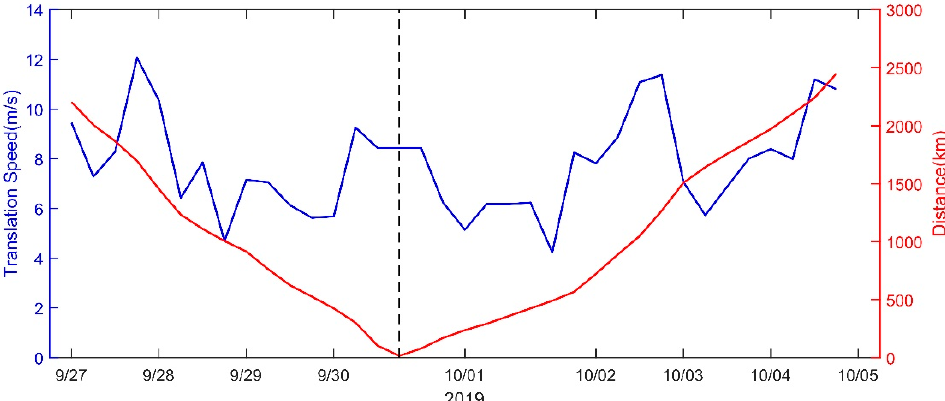
Figure 2. Translation speed (blue solid line) and distance between typhoon Mitag’s center and the mooring over time from when typhoon Mitag was generated. The horizontal axis is time, left vertical axis is translation speed (m/s), and right vertical axis is distance (km).